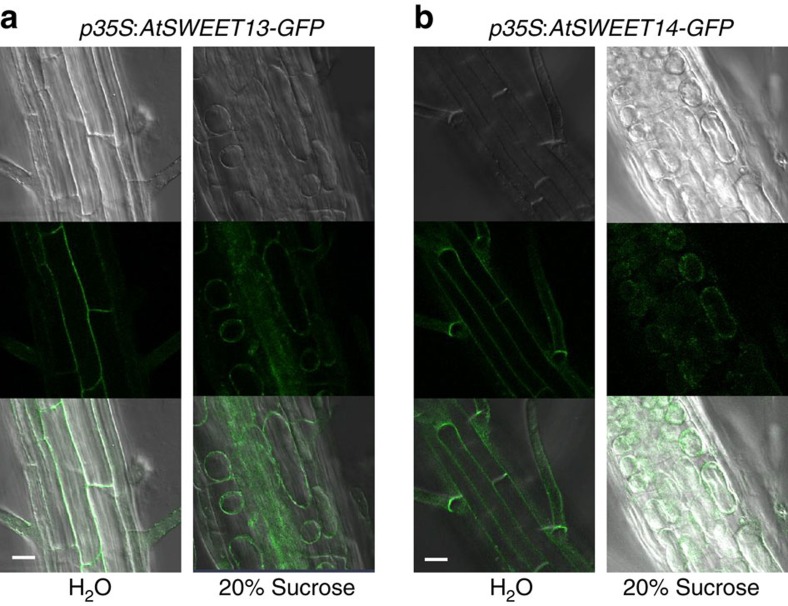
Subcellular localization of AtSWEET13 and AtSWEET14.(a) GFP fluorescence in p35S:AtSWEET13-GFP transgenic plants. (b) GFP fluorescence in p35S:AtSWEET14-GFP transgenic plants. For (a,b), roots of 1-week-old seedlings treated with water (H2O) or 20% (w/v) sucrose were used for observations. Upper panels are bright-field images. Middle panels are images of GFP fluorescence. Lower panels are merged images of bright-field and GFP fluorescence. Scale bars, 20 μm.